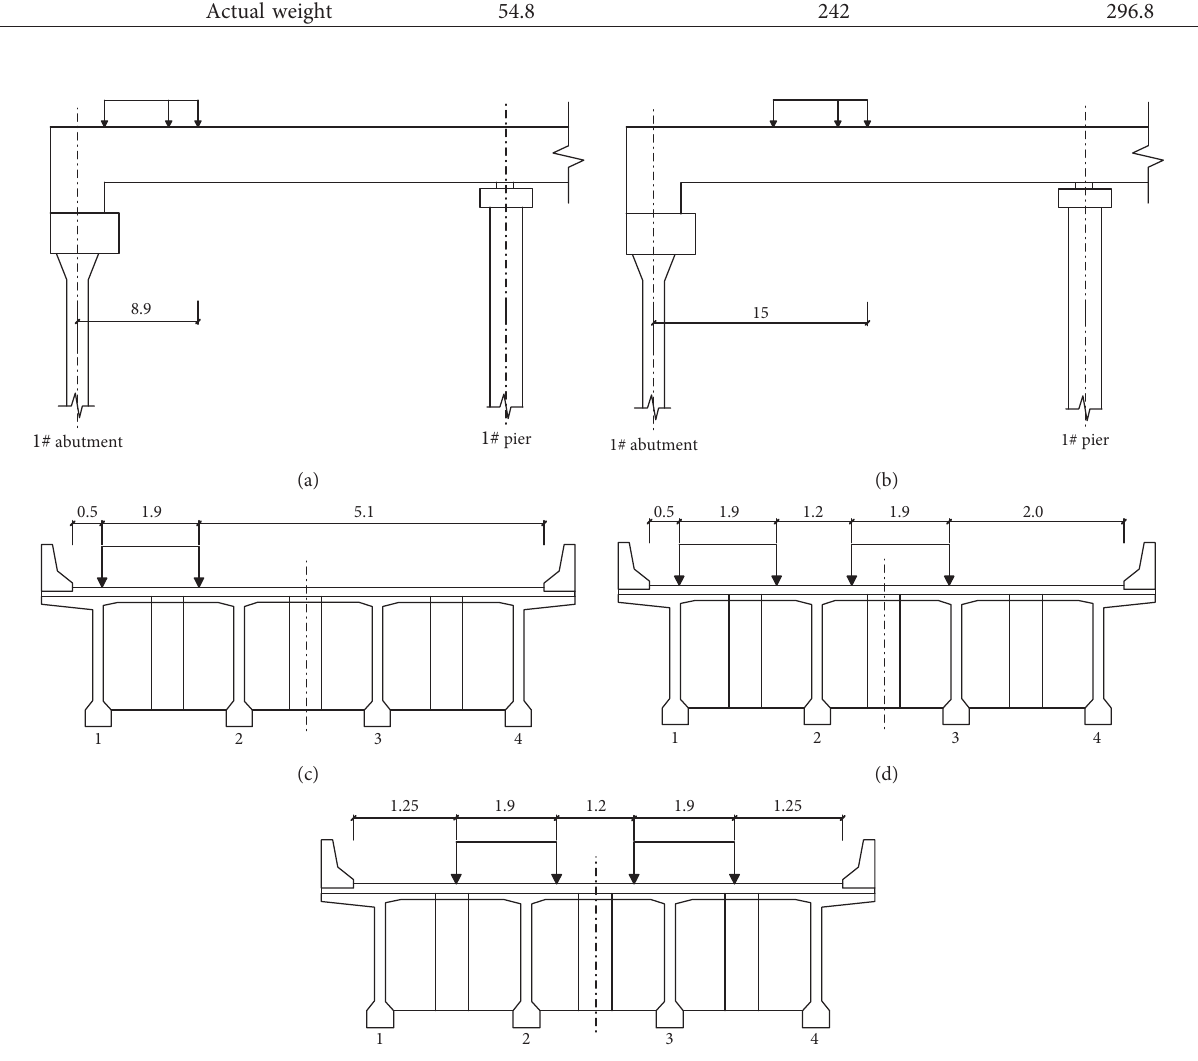
Figure 14: Load conditions (dimensions in m). (a) Longitudinal vehicle load condition I. (b) Longitudinal vehicle load condition II. (c) Transverse vehicle load condition 1. (d) Transverse vehicle load condition 2. (e) Transverse vehicle load condition